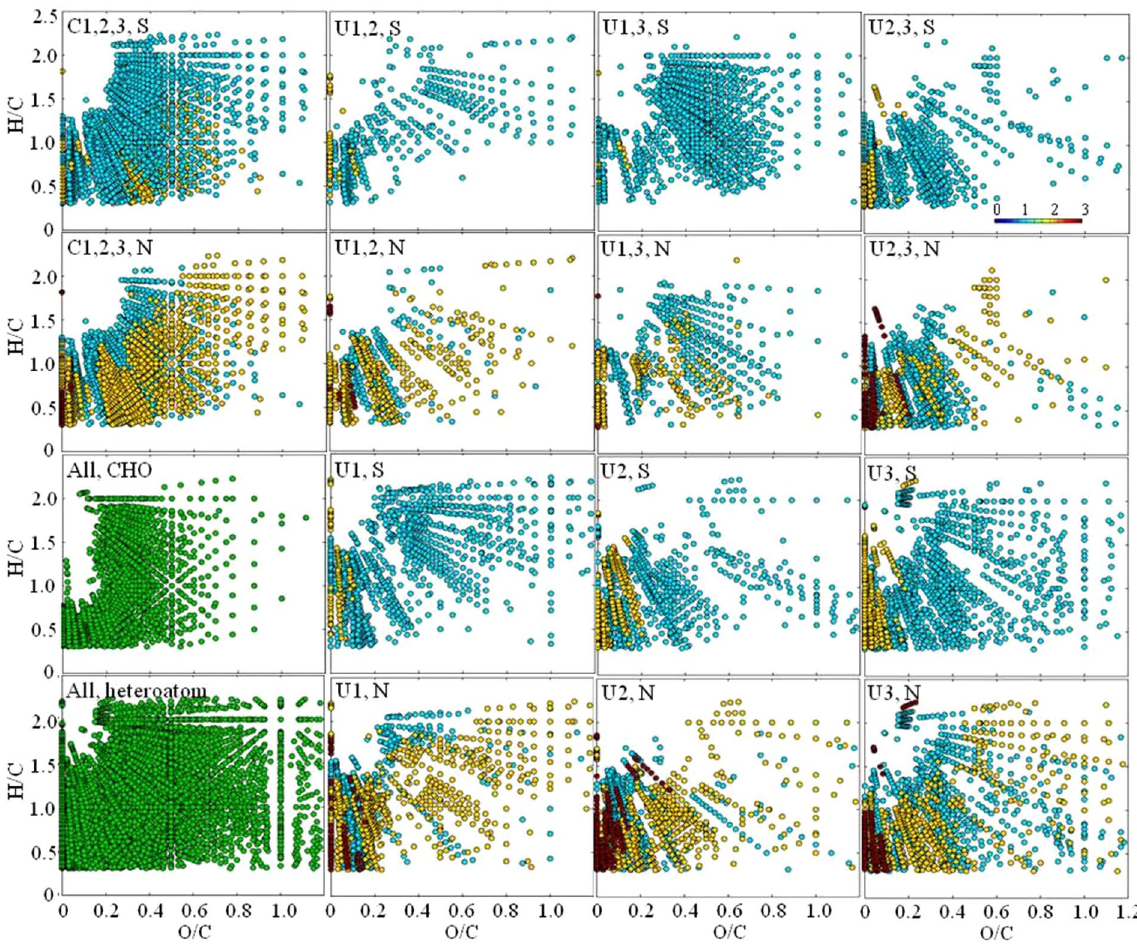
Figure 7. van Krevelen diagrams of all molecular formula diagrams (green) and common (C) and unique (U) heteroatomic (N and S) formula among three sub-groups (1–3) for AEOM at site U1. Light blue: 1-heteroatom; yellow: 2-heteroatom; dark red: 3-heteratom; green.